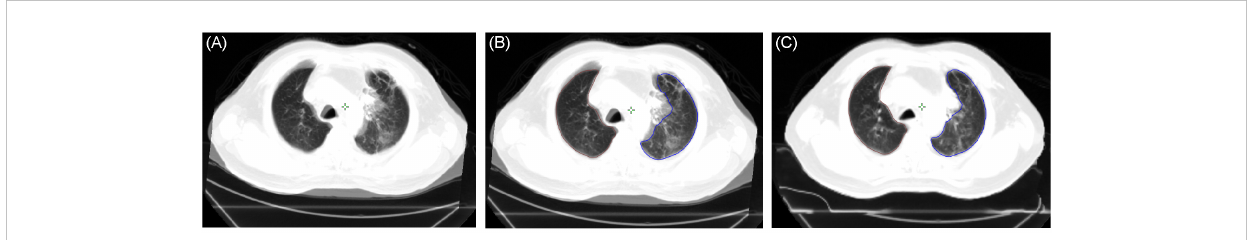
FIGURE 1 (A) Merged image of the post-radiotherapy CT and pre-treatment CT simulation based on a rigid registration process and showing signi fi cant inconsistency between respiratory status and lung volumes. (B) Lung volume of the pre-treatment CT simulation (blue: left lung, brown: right lung) projected on the post-radiotherapy CT (based on the rigid registration process). (C) Lung volume of the pre-treatment CT simulation projected on the post-radiotherapy CT (based on deformable image registration). CT, computed